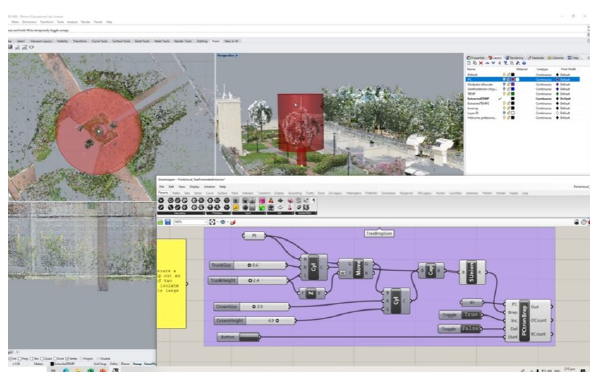
Figure 16. A GUI to interface different data